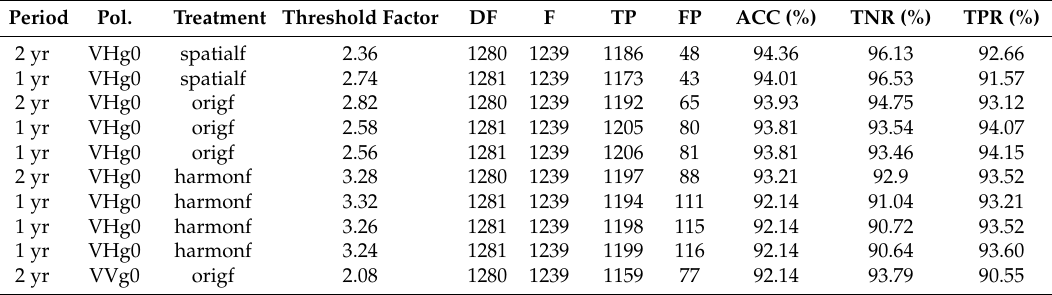
Table 4. Final results of the maximum likelihood classification (MLC) detection (only 10 best results in terms of global accuracy showed). DF = Number of deforested TS, F = Number of forest TS, TP = True positives, FP = False positives FP = False positives, TNR = True Negative Rate, TPR = True Positive Rate, ACC = Global